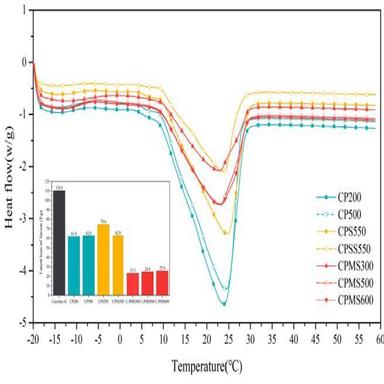
Differential scanning calorimetry (DSC) graphs and latent heat of LHSBCs.